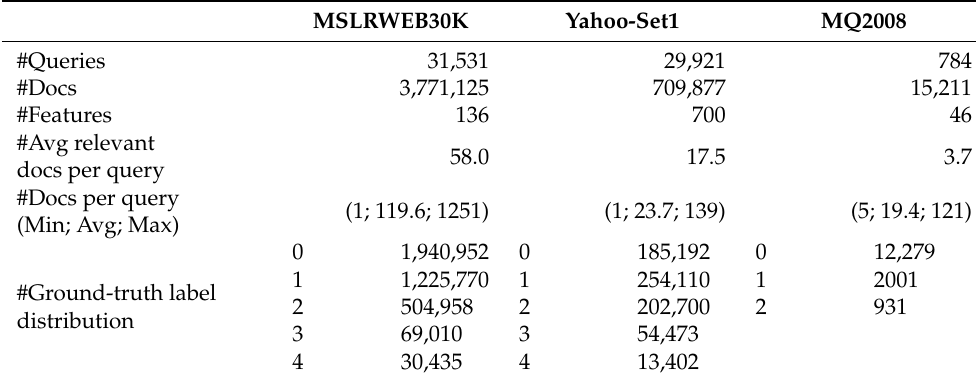
Table 1. The statistics of adopted